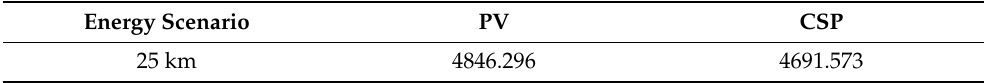
Table 7. Produced H 2 in the second pathway from PV and CSP in (kg × 10 6